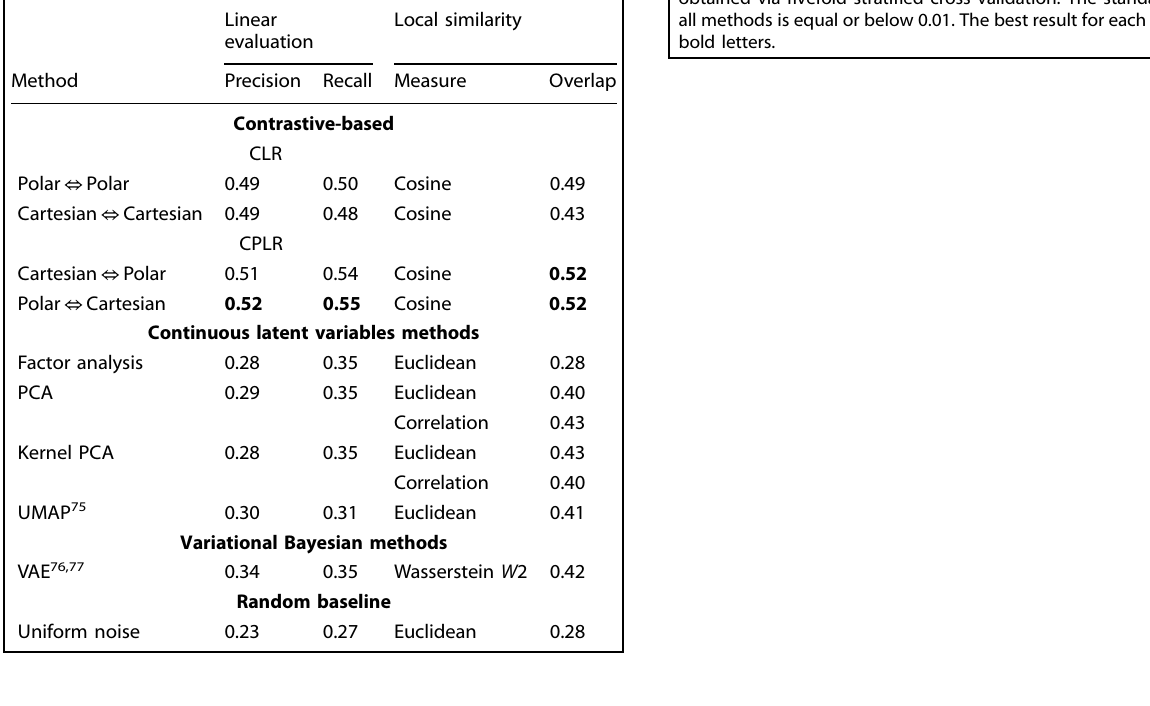
helium nanodroplets